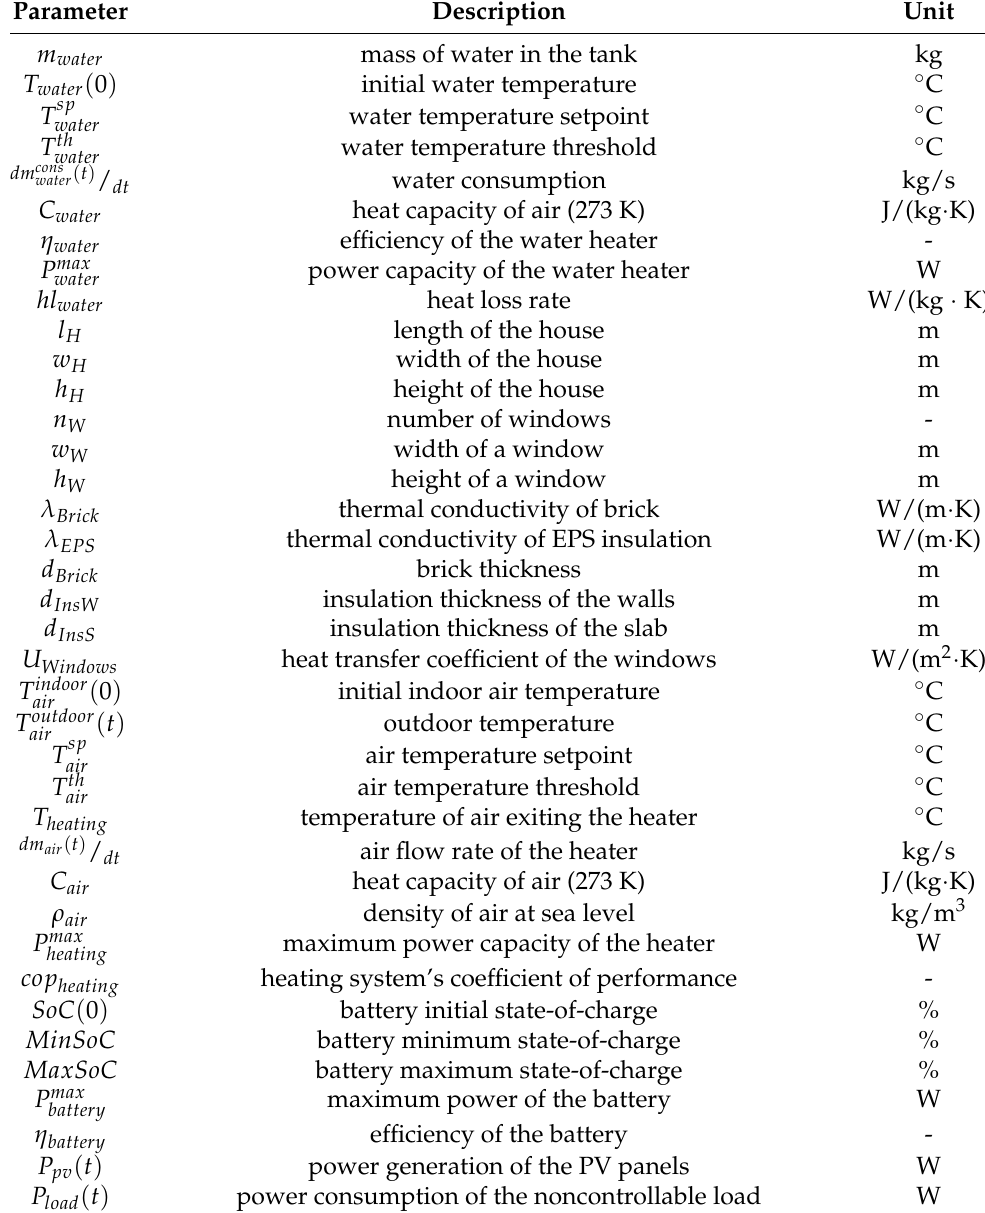
Table 1. Exogenous variables of the